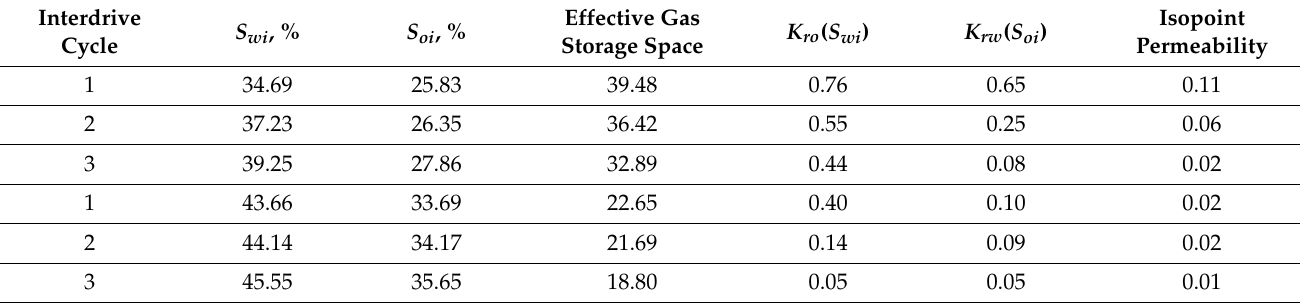
Table 3. Characteristic Values of Multiwheel Oil and Water Drive with Different